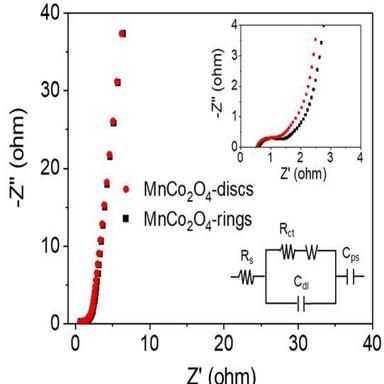
Nyquist plots of MnCo2O4-discs and MnCo2O4-rings; the inset shows the enlarged plots in the high-frequency region and a fitted equivalent circuit.